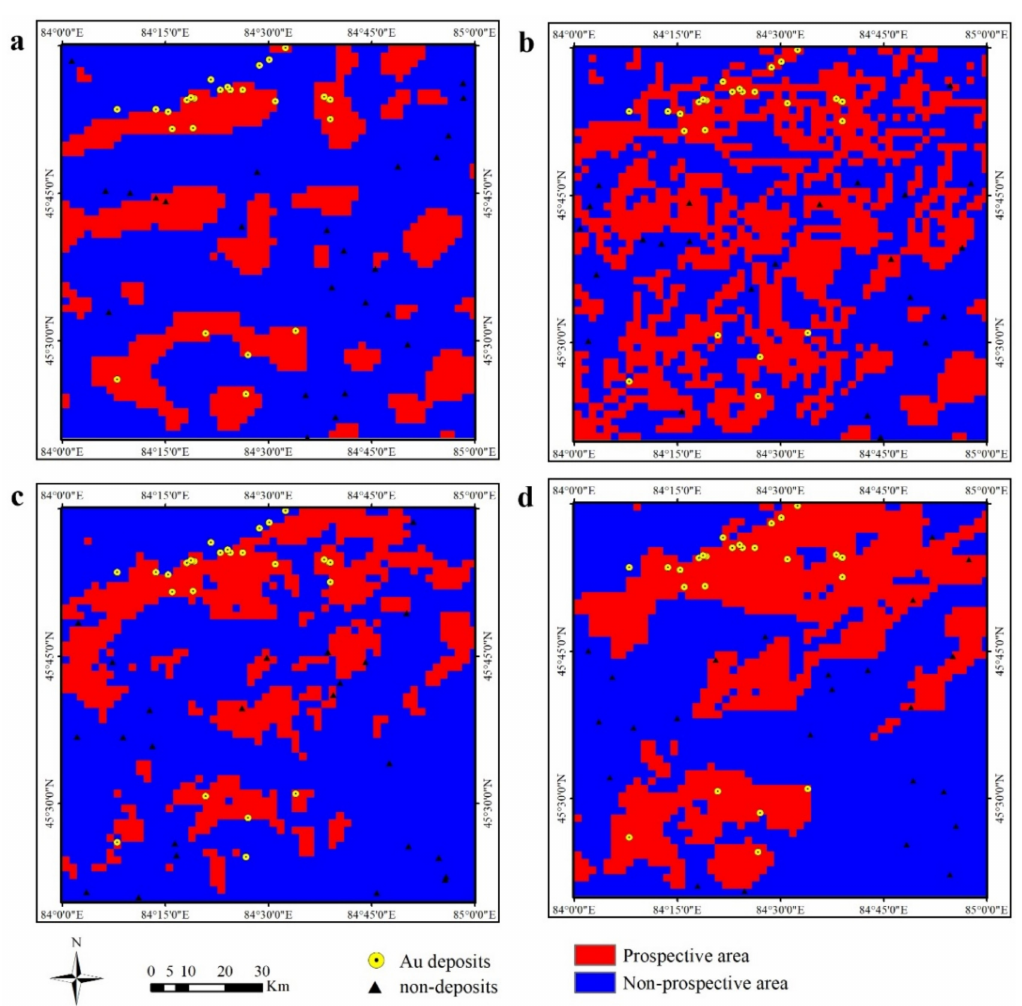
Figure 8. Prospectivity maps generated using GA–SVM model: ( a ) training dataset 1; ( b ) training dataset 2; ( c ) training dataset 3; ( d ) training dataset